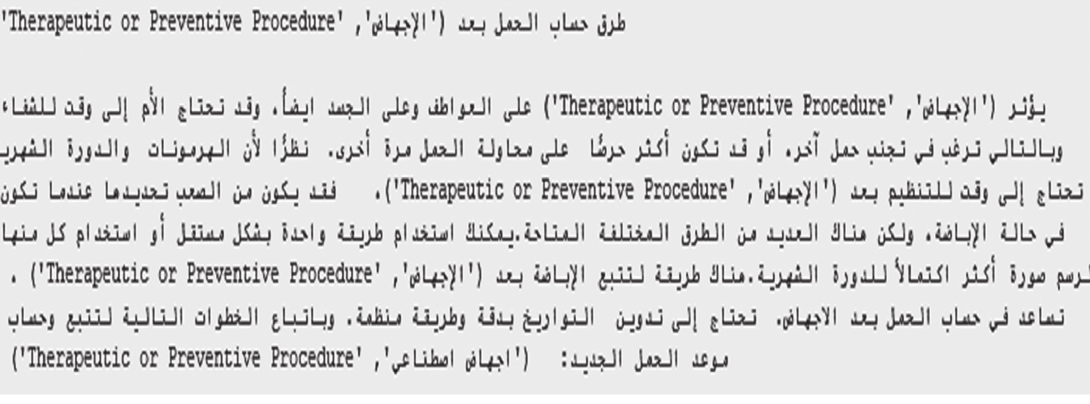
Figure 3: A sample of annotated text.